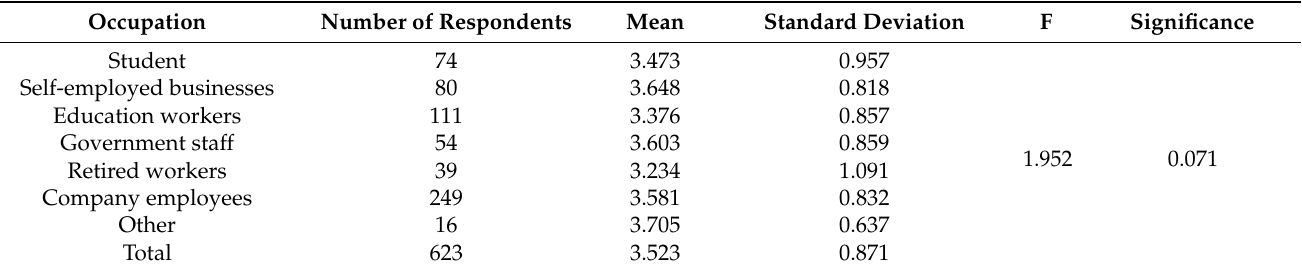
Table 16. Results of the test for differences in waste-sorting behavior among respondents of different occupations.